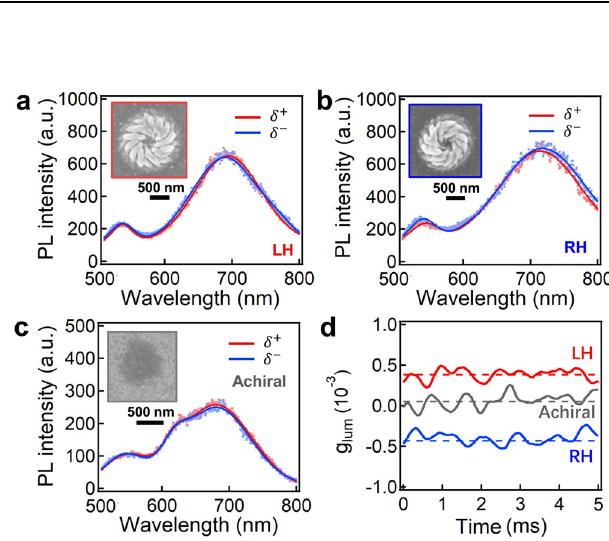
Fig. 5 | Chiroptic property of chiral PdO 2 − x nanostructures. a SEM image of RH PdO 2 − x arrays in sub-millimeter scale. b – d SEM images of PdO 2 − x nanoarrays with b LH, c RH, and d achiral con fi gurations. e CDS spectra of the PdO 2 − x nanoarrays shown in b – d . Source data are provided as a Source Data fi